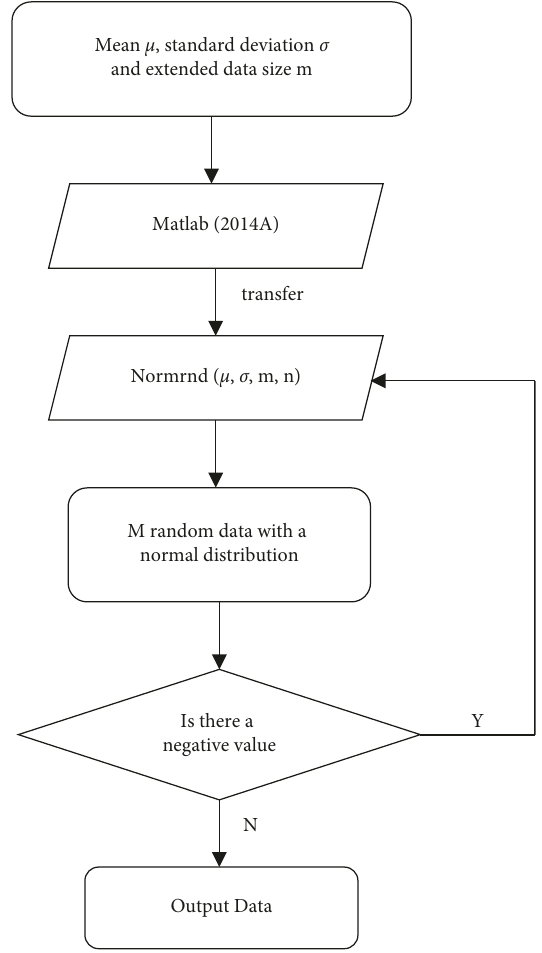
Figure 2: Normal expansion flow